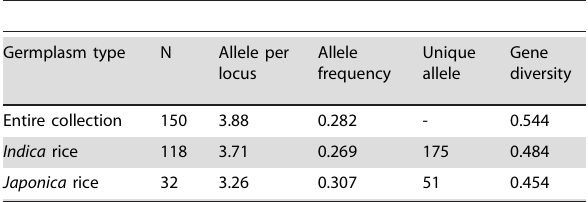
Table 4. Genetic diversity for the entire collection and different germplasm types.